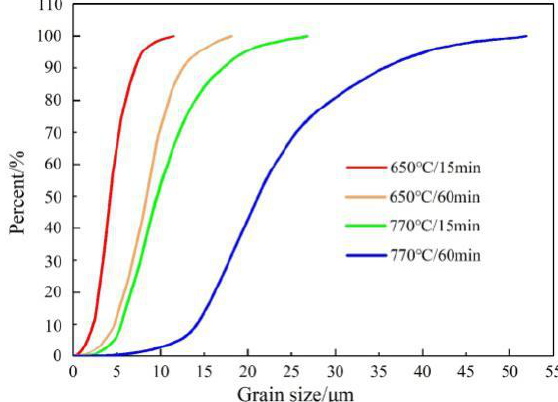
Figure 4. Normalized cumulative frequency vs. grain size (including twin boundaries) of annealed Cu-2.7Be sheets.